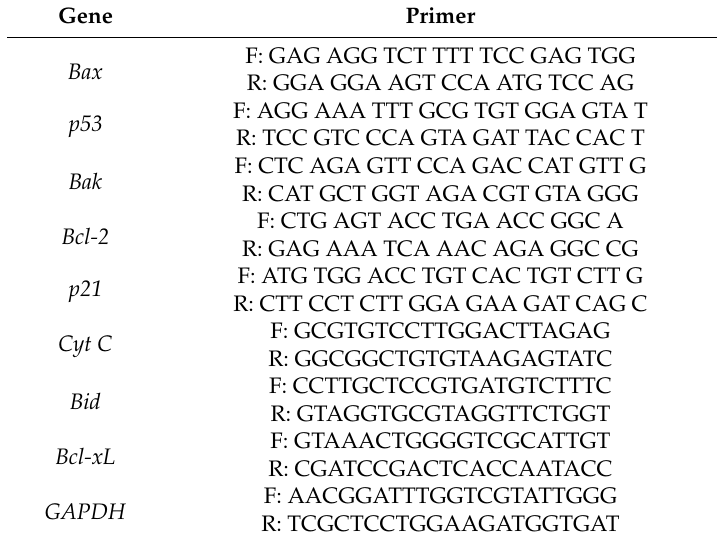
Table 1. Primers used for quantitative real-time PCR for the analysis of apoptotic and anti-apoptotic gene